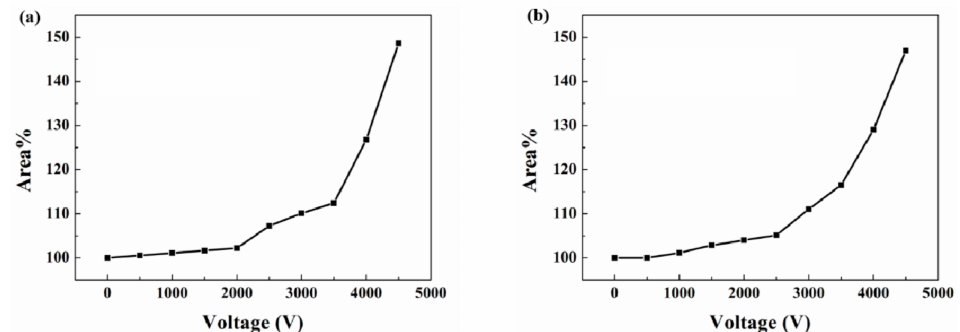
Figure 7. Area change rate of the flexible actuators: ( a ) flexible actuator based on SNP-reinforced ionogels; ( b ) flexible actuator based on carbon